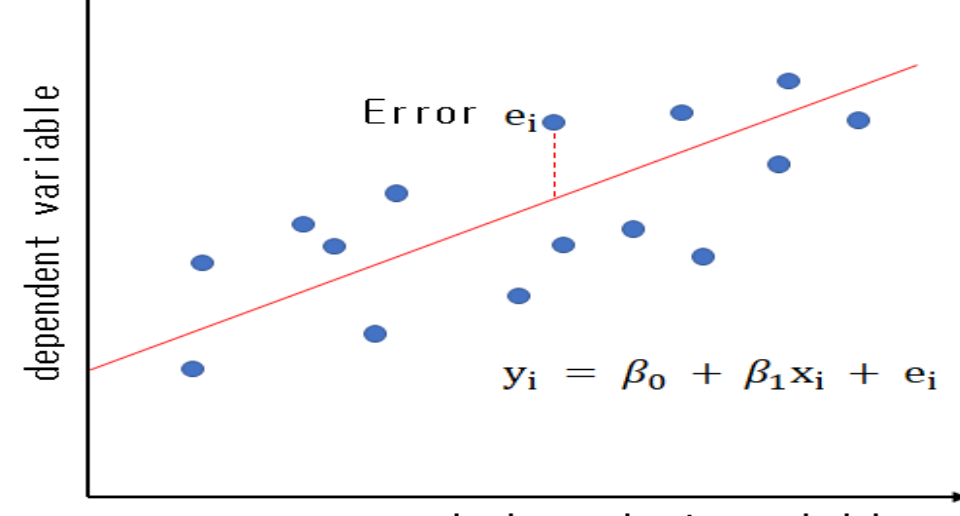
Figure 12. Linear regression model concept.